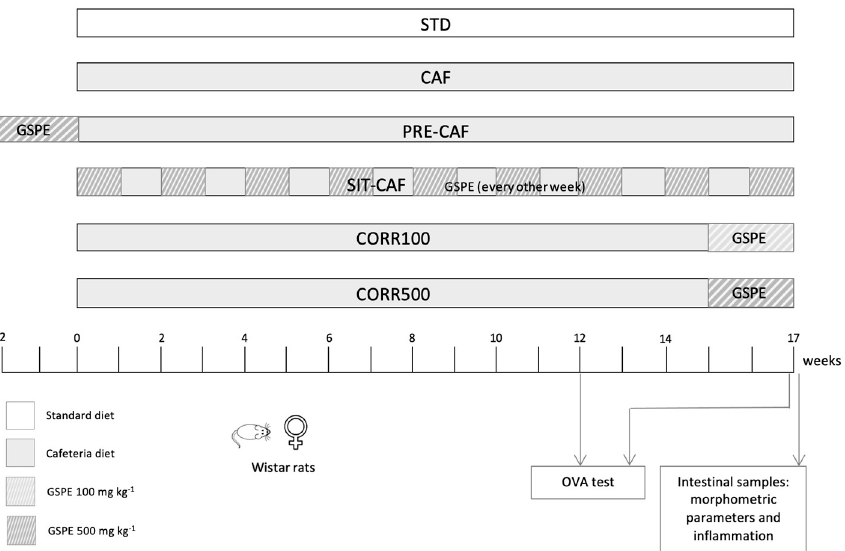
Figure 1. Experimental design. Schematic diagram of the animal experimental design. STD, rats fed